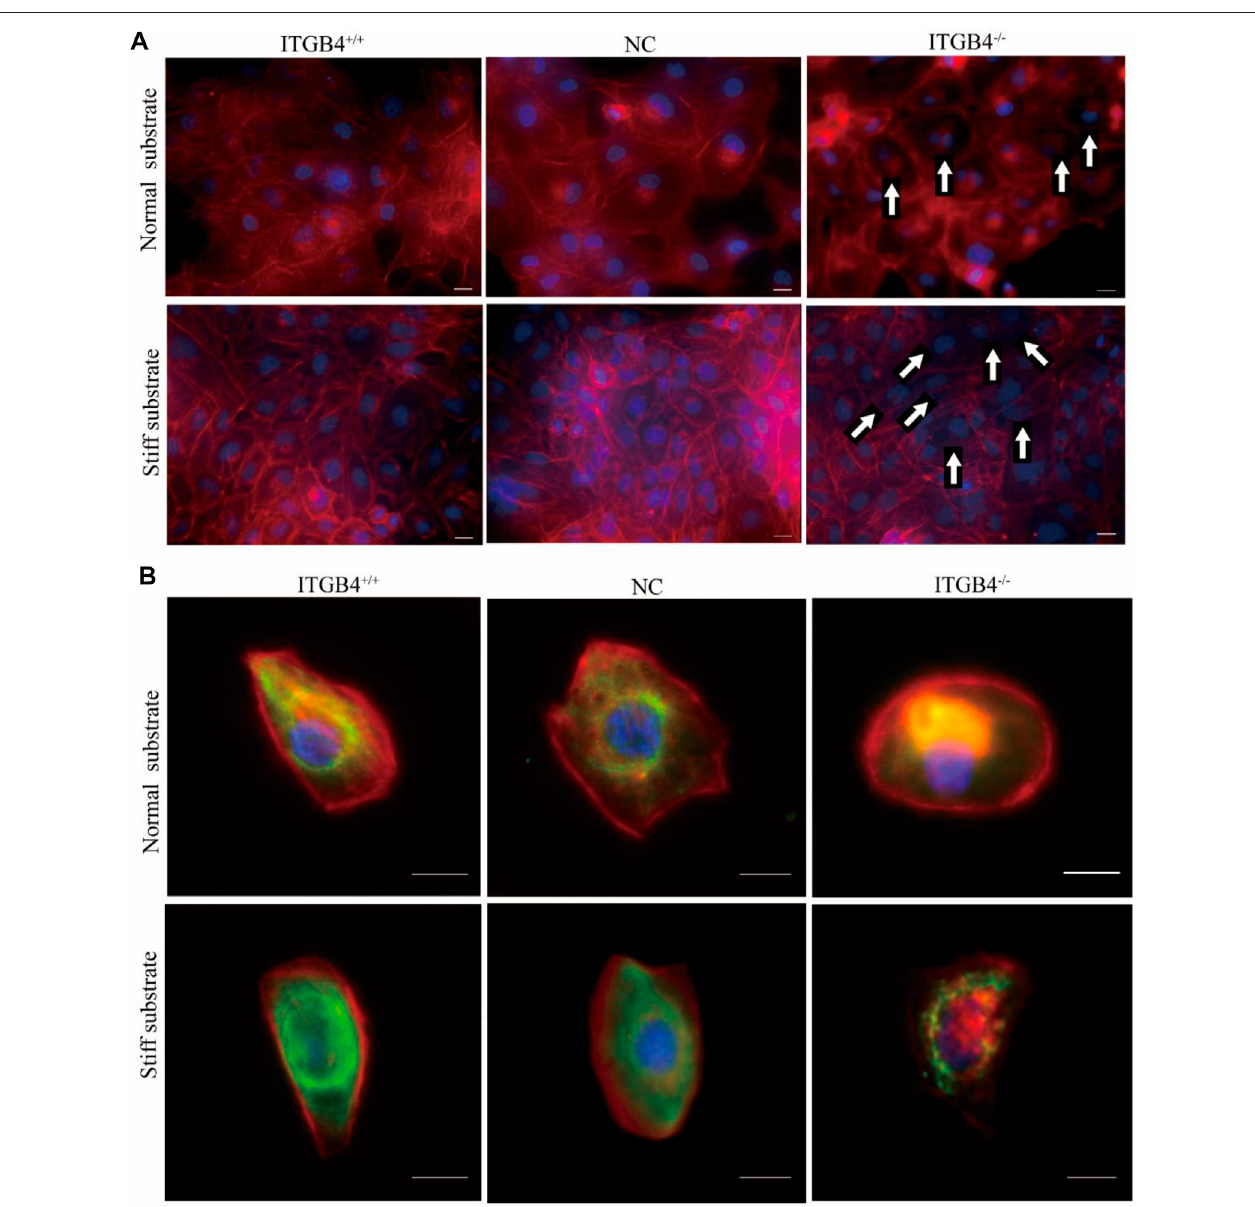
FIGURE 8 | Cytoskeletal morphology of cells on the normal and stiff substrates. (A) Confocal images of cells immunostained for F-actin. (F-actin staining with Phalloidin, Nuclear staining with DAPI) (The arrow shows that F-actin aggregates in the perinuclear area of cells cultured on normal substrate, and that F-actin mostly vanishedinthecellscultureonstiffsubstrate). (B) Confocalimageofcellsdual-labeledforactinandvimentin.Red fl uorescenceindicatesF-actin,andgreen fl uorescence indicates vimentin.